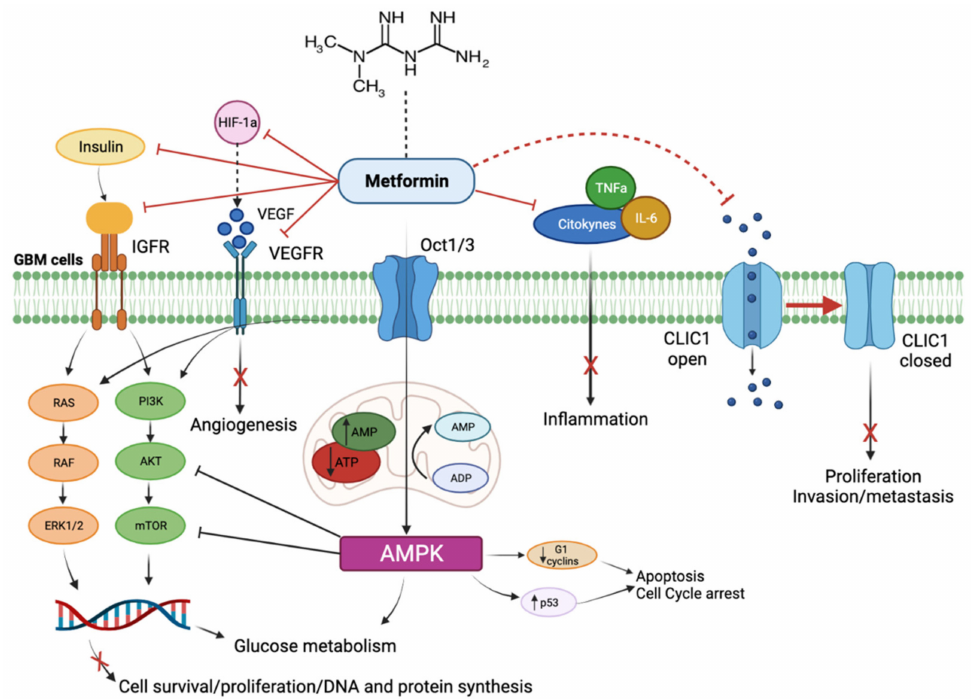
Figure 3. Schematic representation of cellular and molecular effects of metformin on glioblastoma cells. As described in the text, metformin acts by inhibiting IGFR- and VEGFR-mediated pathways, which physiologically lead to angiogenesis, cell proliferation and survival. Furthermore, metformin decreases inflammation and promotes cell cycle arrest and tumor cell apoptosis, by inhibiting cytokine activation and by maintaining the chloride channel 1 (CLIC1) in a closed